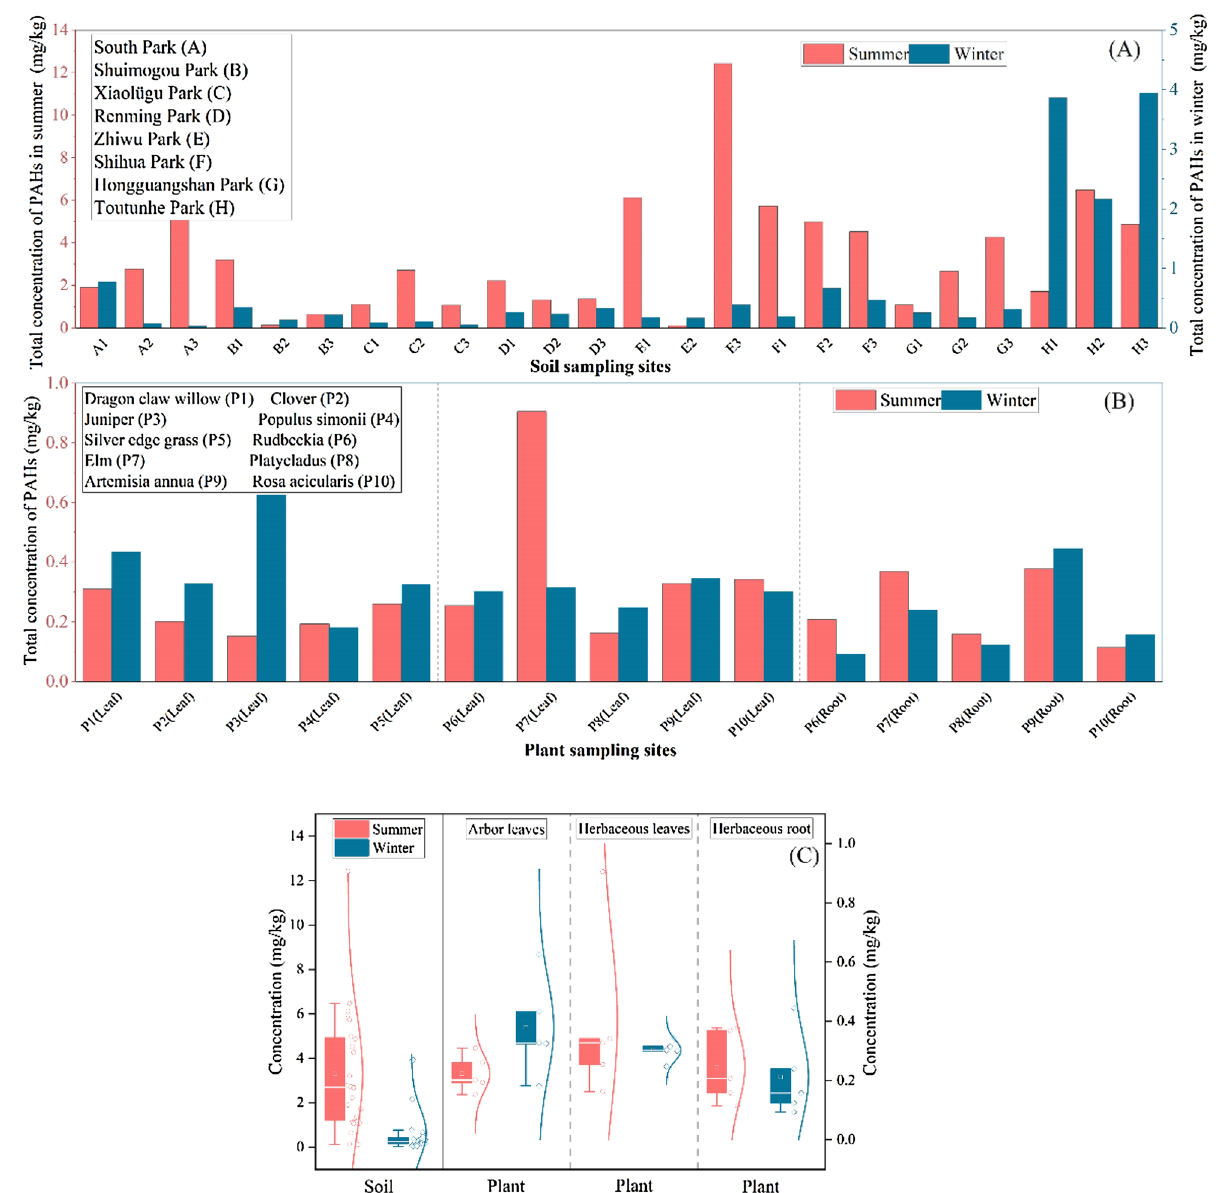
Figure 1. Total concentration distribution of PAHs in park soil and plants.